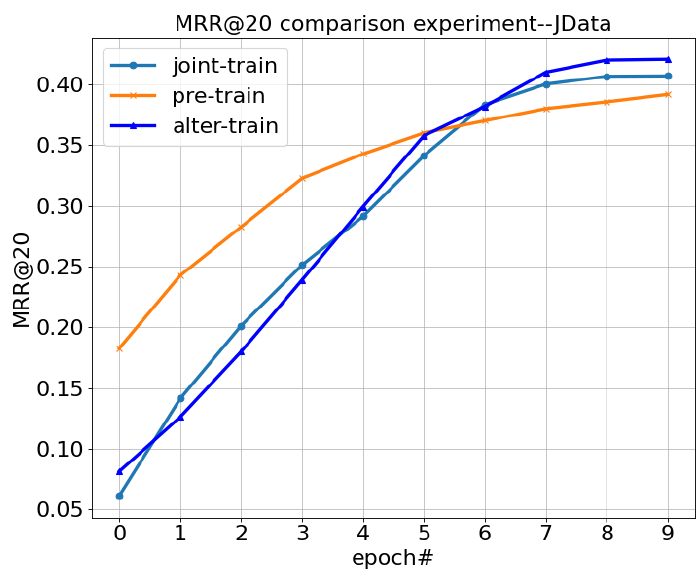
Figure 9. MRR@ 20 curve change chart—JData.